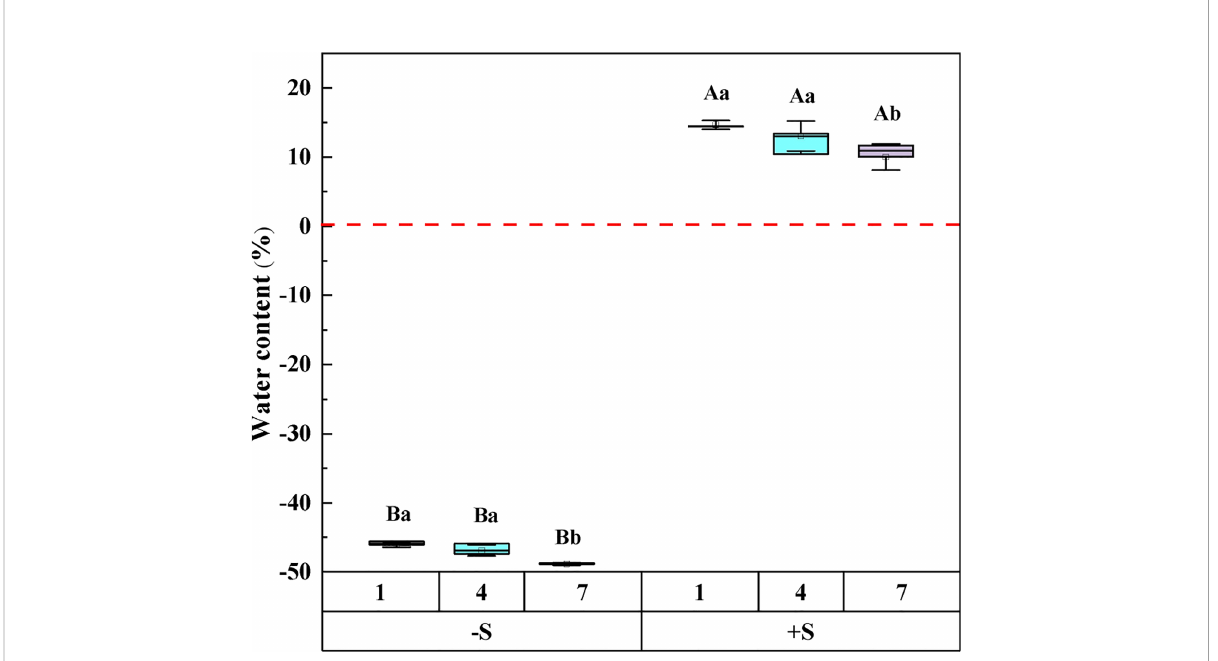
FIGURE 1 The effect of snow depth and snow years on the water content of Syntrichia caninervis . -S represents snow removal, +S represents double snow. Data are means ± SEM, n = 5. Different capital letters and lowercase letters indicate signi fi cant differences (P < 0.05) between treatments of snow depth and snow years,